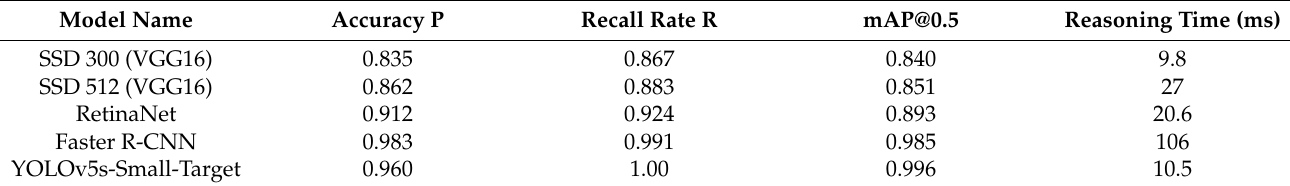
Table 2. Comparison of detection results of each algorithm.